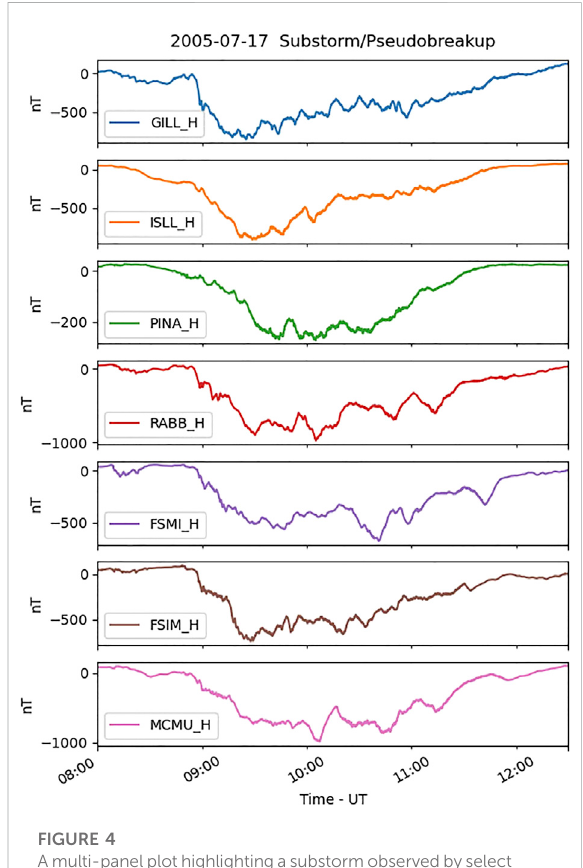
FIGURE 4 Amulti-panelplothighlightingasubstormobservedbyselect CARISMA magnetometer stations. Data was loaded using the carisma module and plotted using